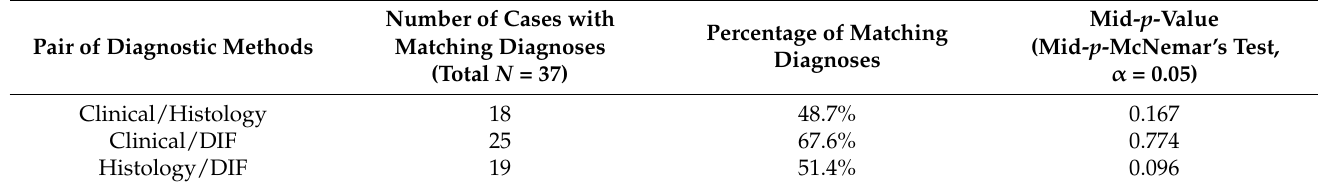
Table 7. Differences Between the Paired Diagnostic Methods Of the Subepidermal Blister Subgroup.